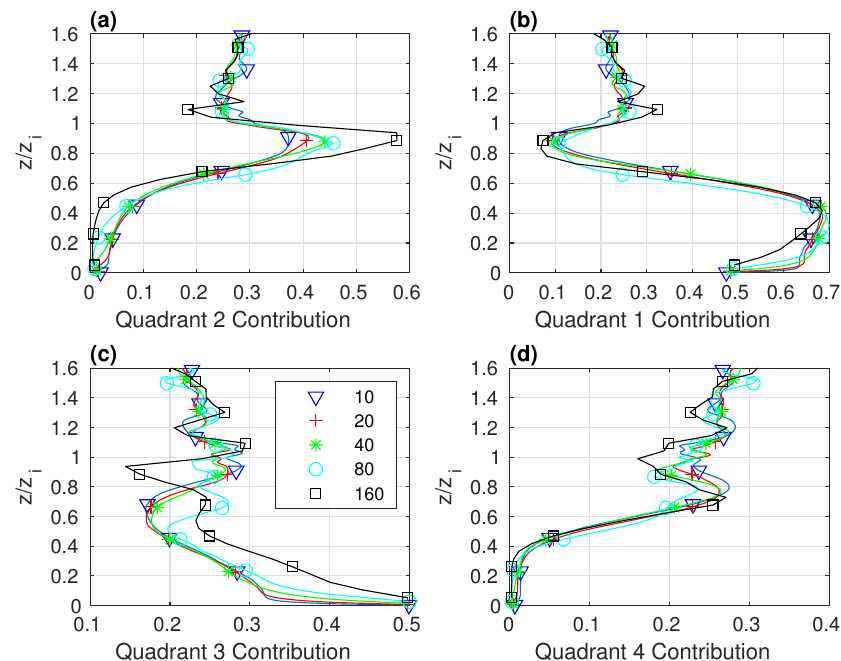
Figure 10. Effect of grid spacing on the partitioning of the resolved potential temperature flux into different quadrants for the CBL1 runs. Relative contributions of the flux in each quadrant, computed as |(cid:104) w (cid:48) θ (cid:48) (cid:105) | / ∑ |(cid:104) w (cid:48) θ (cid:48) (cid:105) | , are shown for ( a ) Quadrant 2, ( b ) Quadrant 1, ( c ) Quadrant 3 and ( d ) Quadrant i i i 4. Each line is for a simulation with a different grid length, the values in m being indicated in the inset.